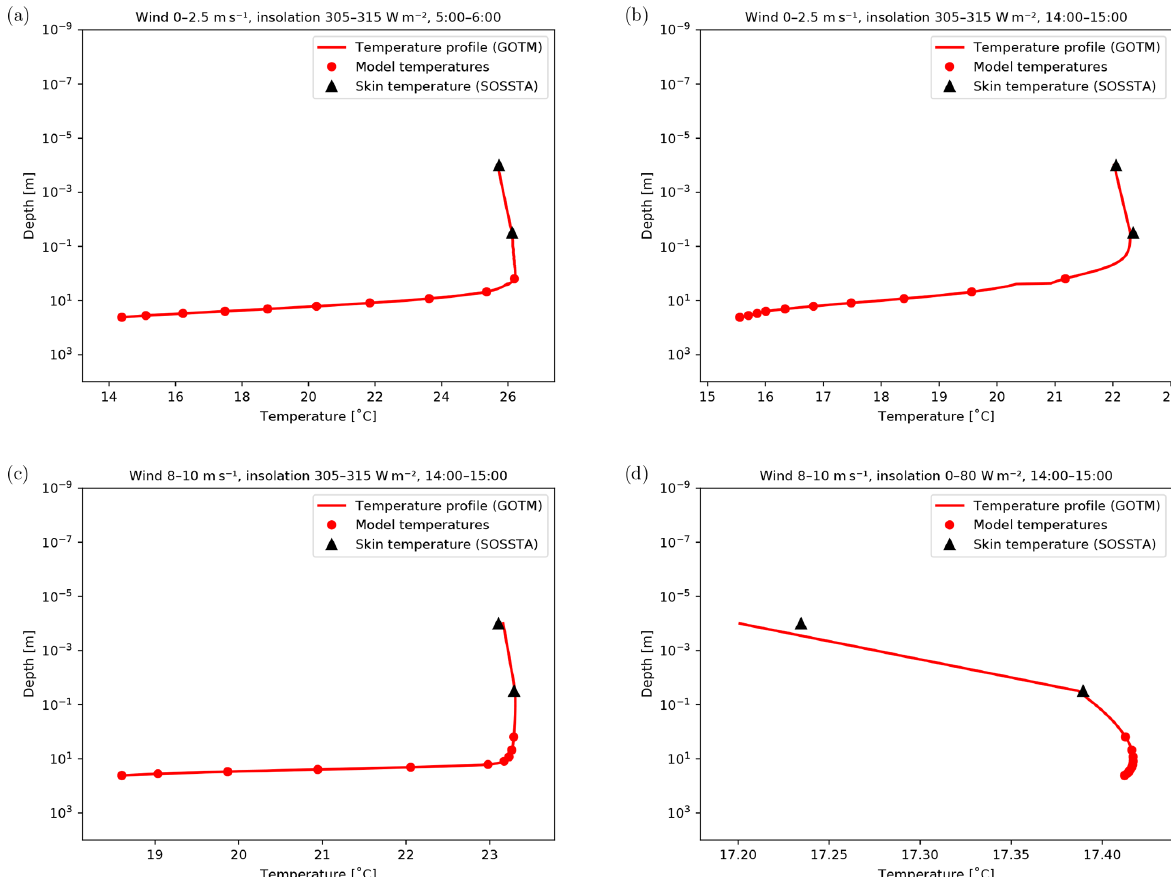
Figure 3. Examples of temperature profiles in various conditions and at different times. The GOTM profiles are shown by the red curve, while the filled circles indicate the values used as input to the CCA OO. The output of the CCA OO is shown by the black triangles. (a) Low wind, high insolation, early morning; (b) low wind, high insolation, afternoon; (c) high wind, high insolation, afternoon; (d) high wind, low insolation,